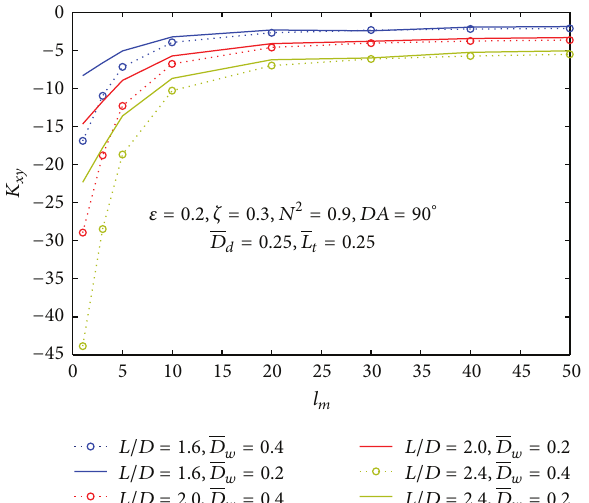
Figure 8: Variation of K 𝑦𝑦 as a function of characteristics length “ l m